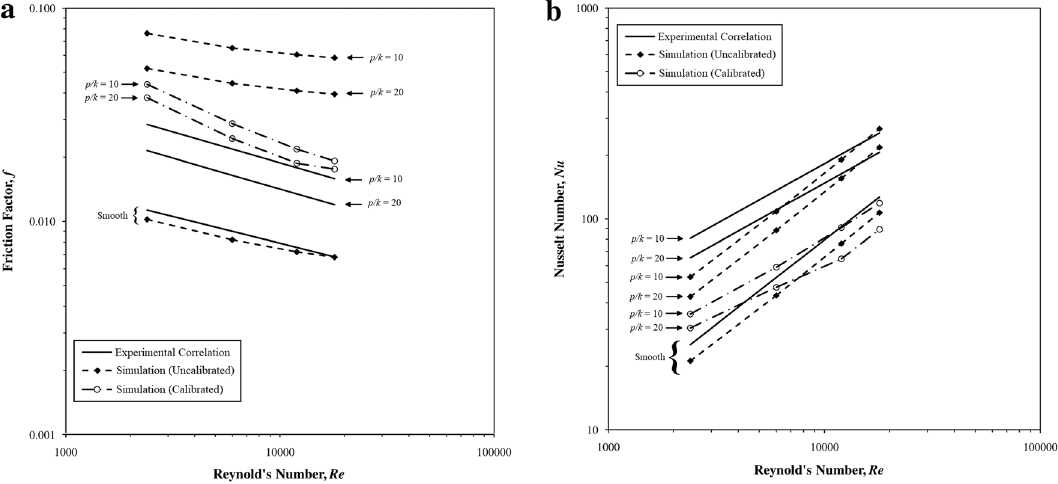
Fig. 13 Comparison of simulated friction factors with experimental correlations for channel height, H = 1.2 mm, b Comparison of simulated Nusselt numbers with experimental correlations for channel height, H = 1.2